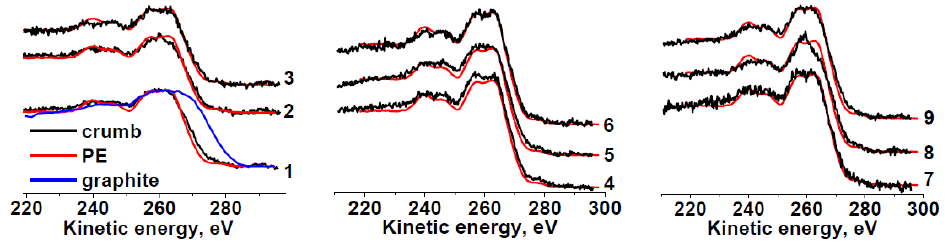
Figure 3. Comparison of C KVV Auger spectra of RC 0-1 — a (1), b (2), c (3); RC 1-3 — a (4), b (5), c (6); RC 3-5 — a (7), b (8), c (9) with spectra of polyethylene (PE) and graphite. Table 3. Parameters of components in C 1s photoelectron spectra of rubber crumbs: E b — binding